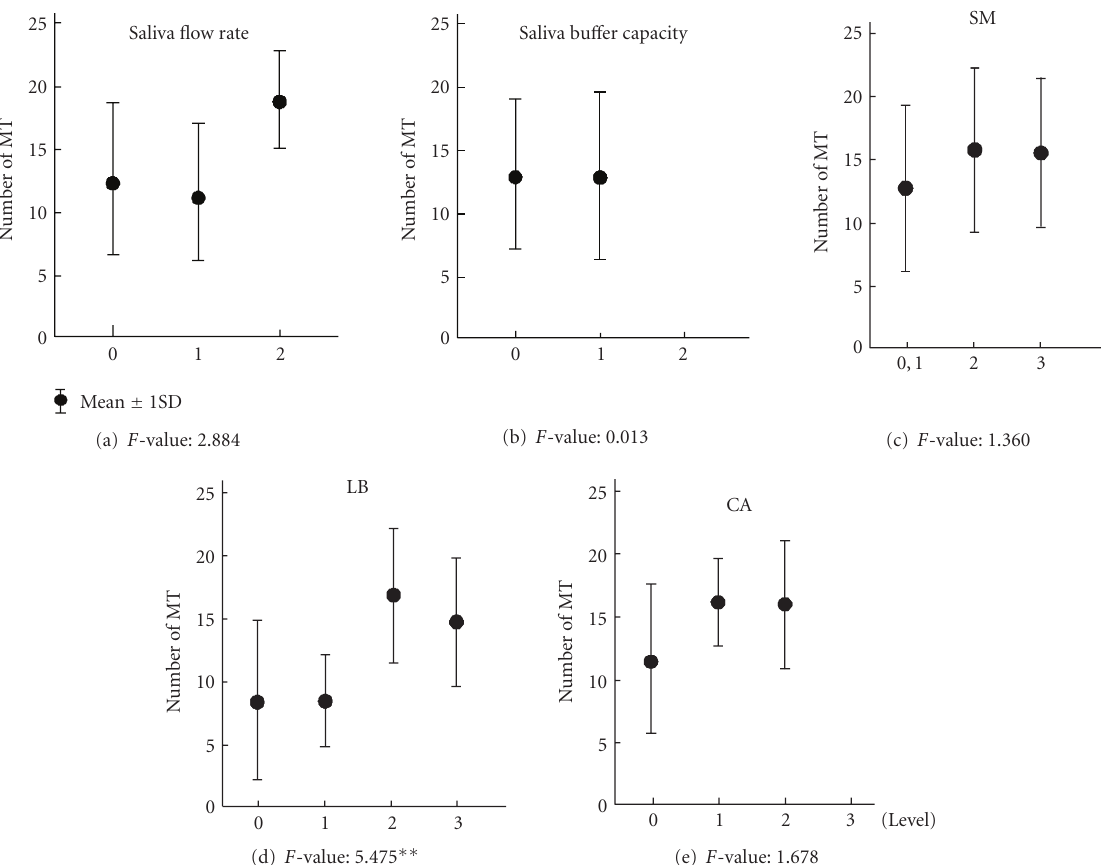
Figure 2: Results of the di ff erences between MT and oral environmental factors in Denture group ( ∗∗ P < .